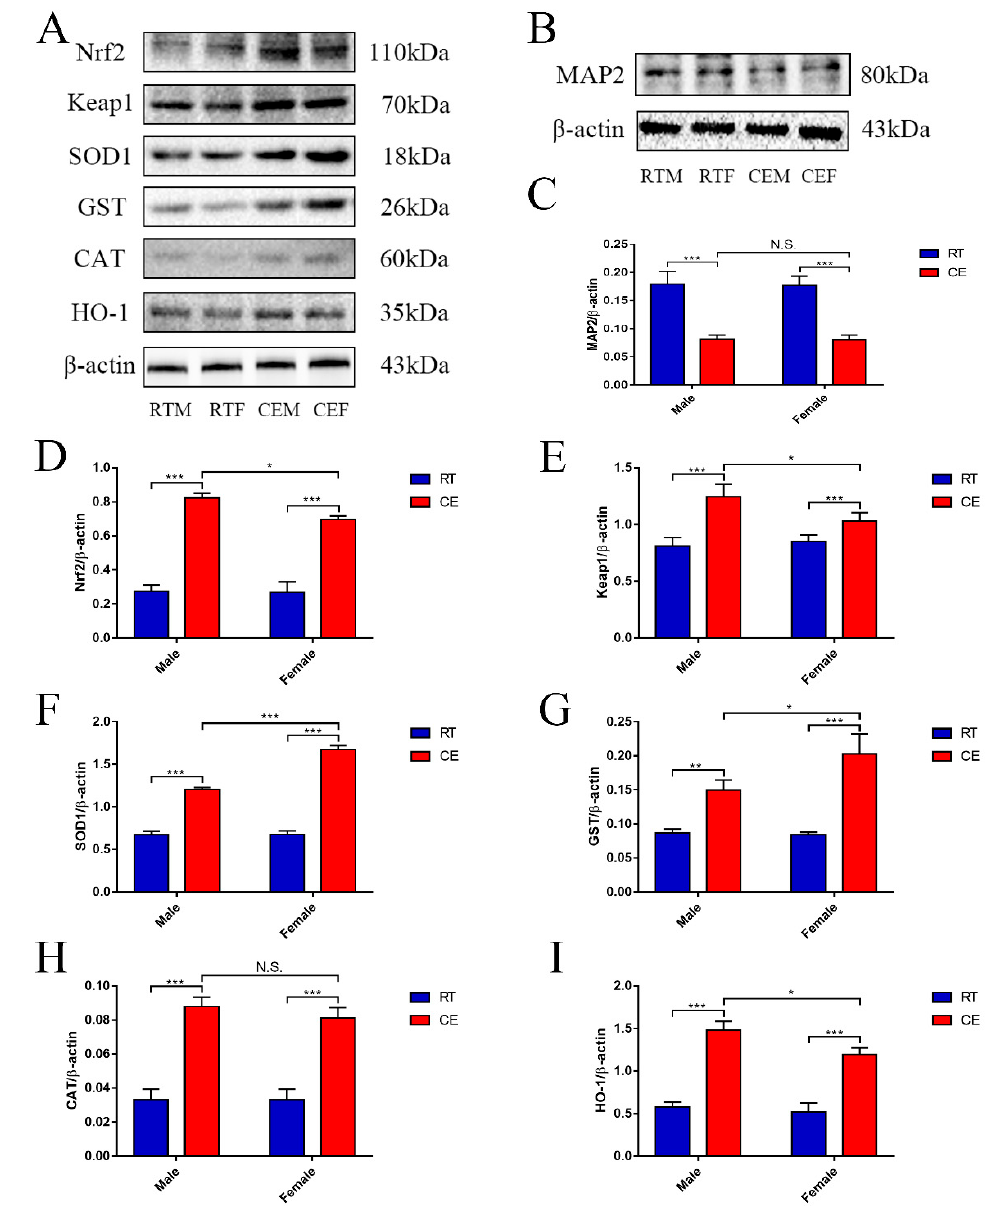
Figure 2. The relevant expression of anti-oxidative proteins ( A ) nuclear factor-like 2 (Nrf2), kelch-like ECH-associated protein 1 (Keap1), Superoxide dismutase 1 (SOD1), glutathione S-transferase (GST), Catalase (CAT), and Heme oxygenase (HO-1), and markers of neuronal dendritic tissue ( B ) microtubule-associated protein 2 (MAP2) and β -actin expression in each group in hippocampus lysates as assessed by western blotting and relative density analysis. Expression levels were quantitated by measuring band intensities using Image Lab software. The graphs indicate densitometric analyses using the expression ratios of ( C ) MAP2 / β -actin, ( D ) Nrf2 / β -actin, ( E ) Keap1 / β -actin, ( F ) SOD1 / β -actin, ( G ) GST / β -actin, ( H ) CAT / β -actin, and ( I ) HO-1 / β -actin. Data were between room temperature male (RTM) vs. cold exposure male (CEM), room temperature female (RTF) vs. cold exposure female (CEF), and CEM vs. CEF and were analyzed by two-way analysis of variance. Results are expressed as the mean ± SD ( n = 6) from four independent experiments. NS: not significant; ** p < 0.01; *** p < 0.001.